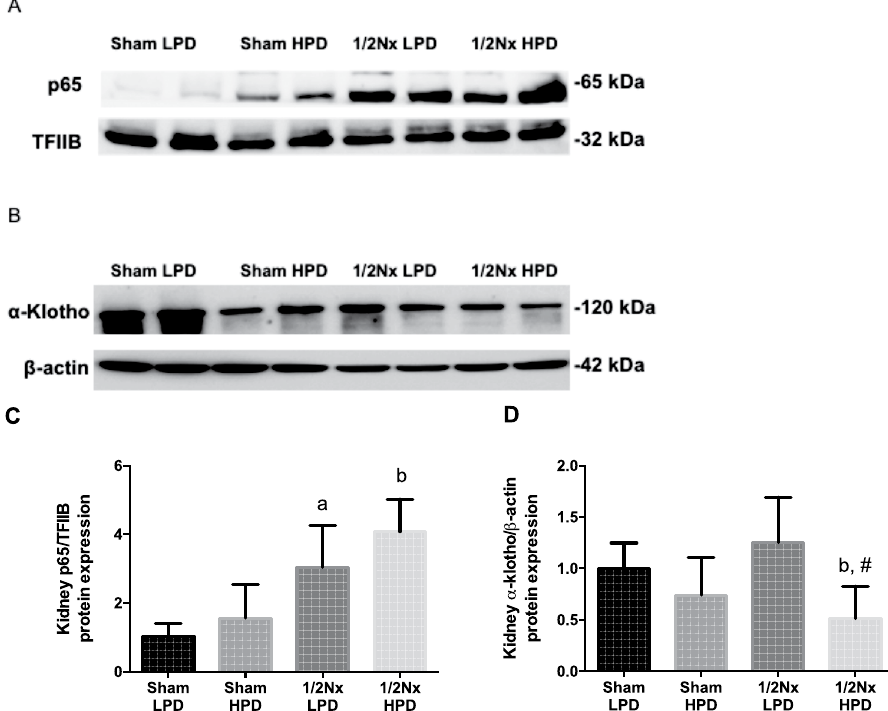
Figure 4. Burden phosphate reduces Klotho and promotes inflammation. Western blotting of protein extracts from kidney tissue. For detection of α -klotho ( A ) was used the cytoplasmic fraction and β -actin as loading control. For p65 fragment from NF-kB ( B ) detection was used the nuclear fraction of renal protein extracts and TFIIB as loading control. Quantification of western blots of Klotho ( C ) and p65 ( D ) were performed by measurement of average relative density and normalized to β -actin levels. a p < 0.05 vs Sham LPD; b p < 0.05 vs. Sham HPD and # p < 0.05 vs. Nx1/2